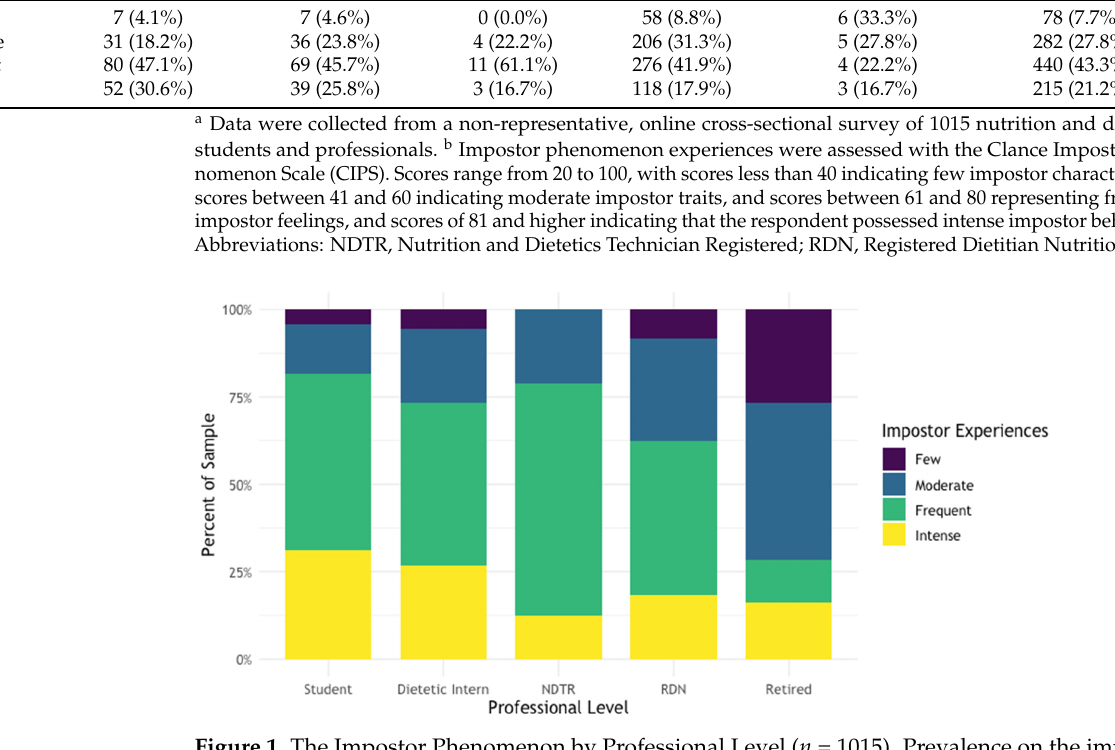
Figure 1. The Impostor Phenomenon by Professional Level ( n = 1015). Prevalence on the impostor phenomenon were assessed with the Clance Impostor Phenomenon Scale among a non-representative sample of nutrition and dietetics students and professionals. Abbreviations: NDTR, Nutrition and Dietetics Technician Registered; RDN, Registered Dietitian Table 2. Prevalence of the Impostor Phenomenon Experiences in Nutrition and Dietetics by Profes- sional Level a .